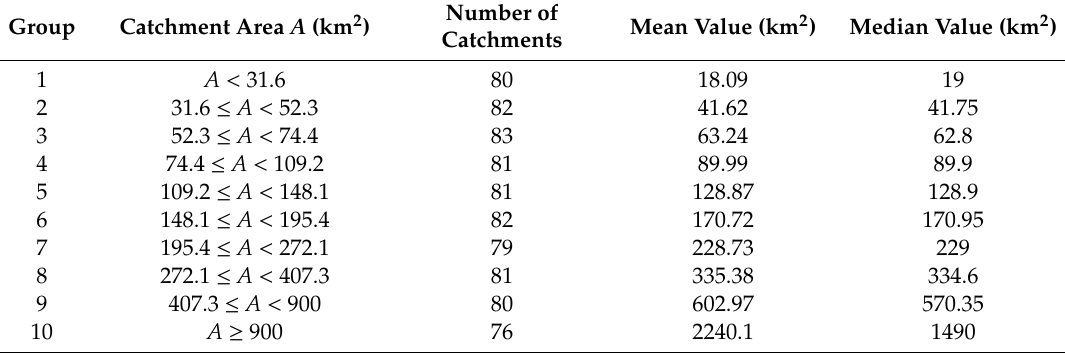
Figure 3. ( a ) Scatterplot (points) and linear least-squares (LS) fit (solid line) of the mean values 𝐸[𝑄 ′ ] of the standardized discharges 𝑄 ′ = 𝑄 ∕ 𝐴 for the 805 considered catchments, with respect to their corresponding SAAR values. ( b ) Same as (a) but for the means 𝐸[𝑄 𝑚𝑎𝑥′ ] of the standardized annual discharge maxima 𝑄 𝑚𝑎𝑥′ = 𝑄 𝑚𝑎𝑥 𝐴⁄ . Table 1. Classification of the selected catchments, according to their size, into 10 approximately equally sized groups.